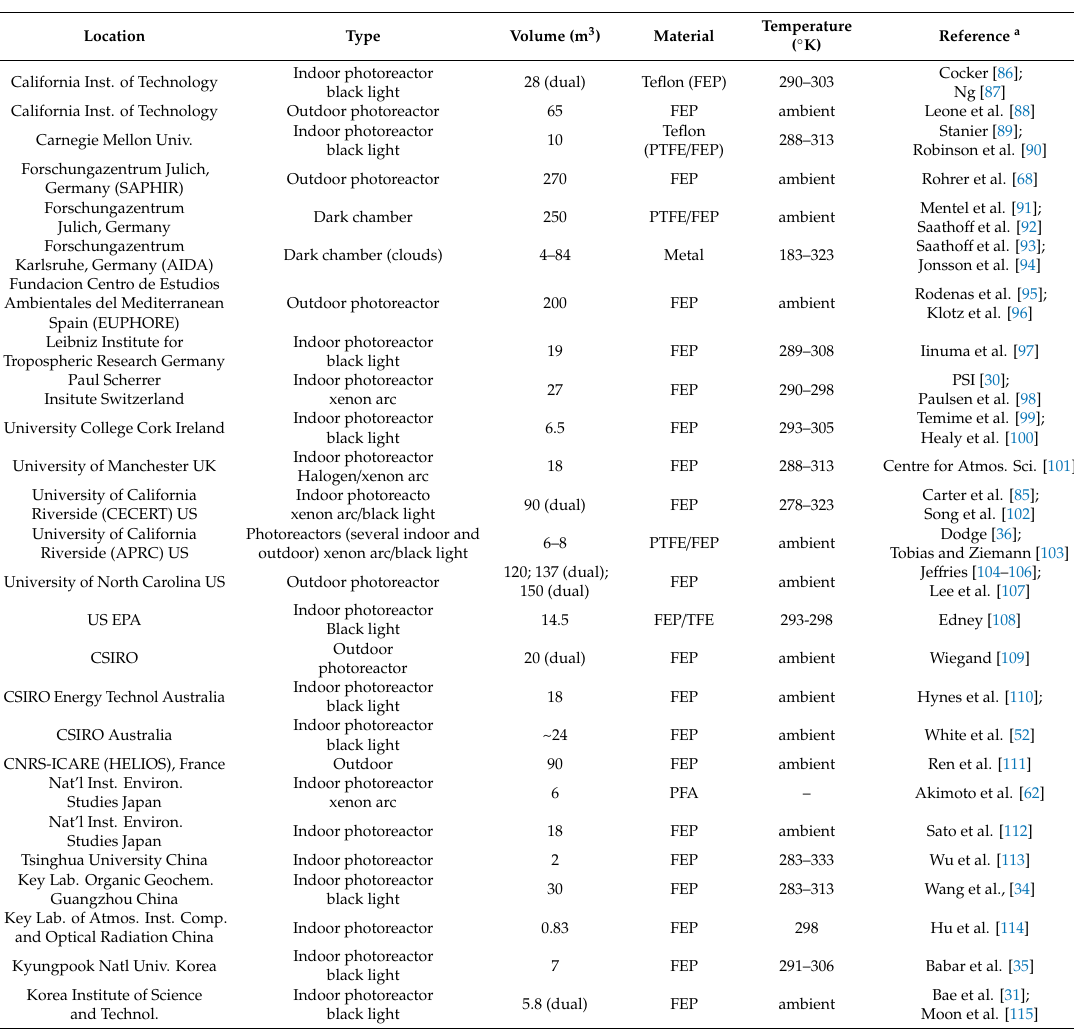
Table 2. Some Smog Chambers Used for Photochemical Gas-Aerosol Studies (updated table from Hallquist et al.